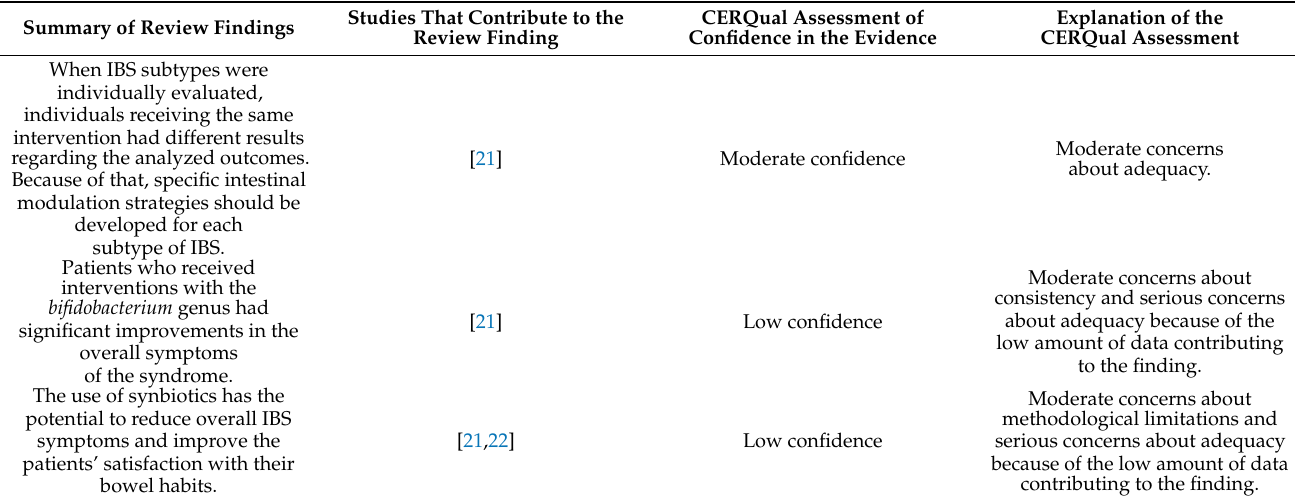
Table A1. Summary of qualitative findings (SoQF).